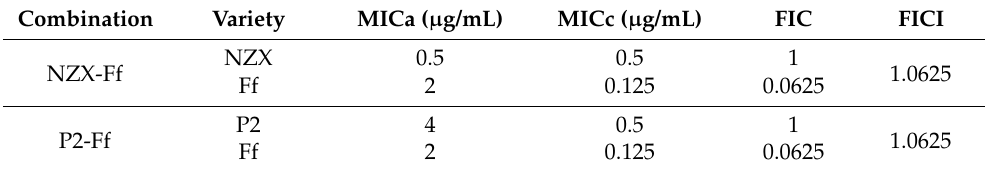
Table 3. Synergism of peptides with